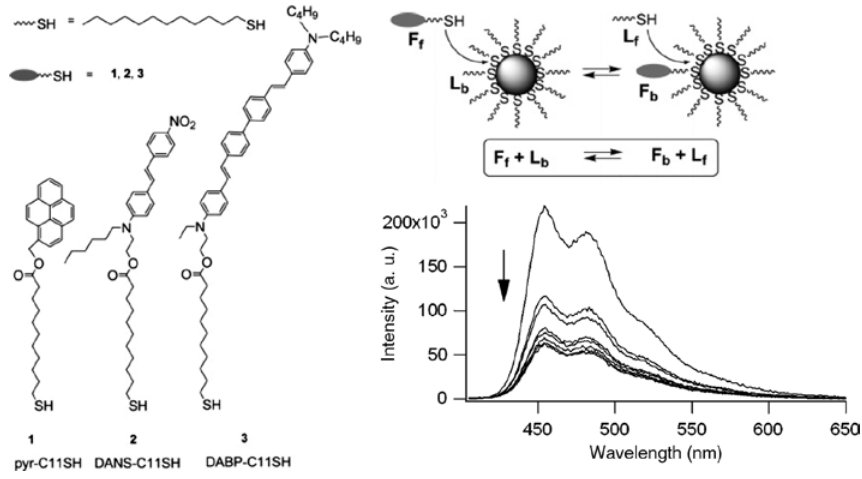
Figure 14: Left: Thiol-modified chromophores. Top right: Ligand exchange reaction. Bottom right: Fluorescence intensity evolution during ligand exchange reaction. Adapted with permission from Ref. [38]. Copyright (2015) American Chemical